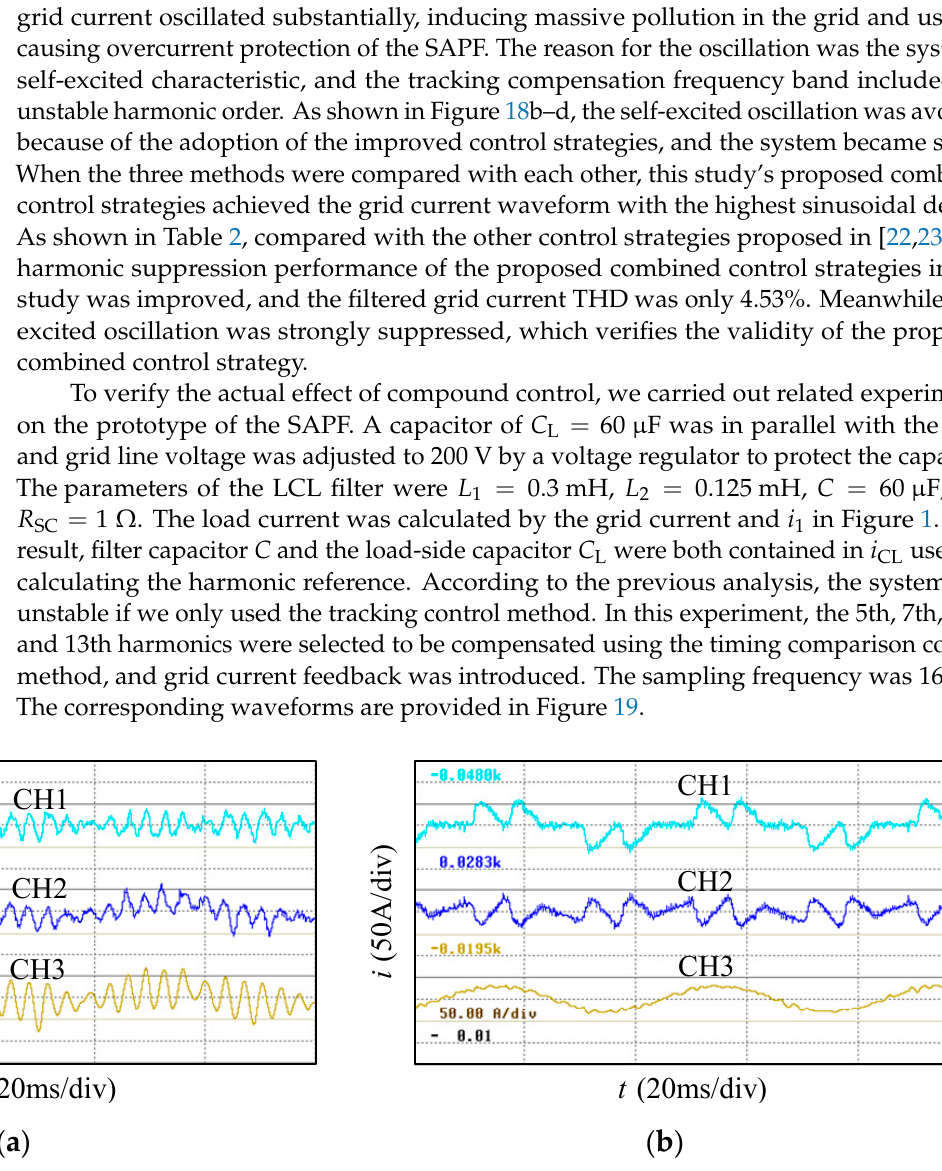
Table 3. Performance of shunt virtual damping control. Harmonic Order ( b ) Figure 20. Grid current of hybrid system ( a ) when β = 2%; ( b ) when β = 6%. In the end, corresponding experiments were implemented on the experimental pro- totype. The RMS value of the grid line voltage was 380 V. On the load side, the three- phase reactors and SCR rectifiers generated controllable reactive power and harmonics, respectively. The grouping method adopted the 4-2-1 rule for the TSC, and the single- phase total compensation capacity of TSC was 24.675 kVA. The value of the series reac- tance ratio β was chosen to be 6% for the TSC prototype. Figure 21 demonstrates the